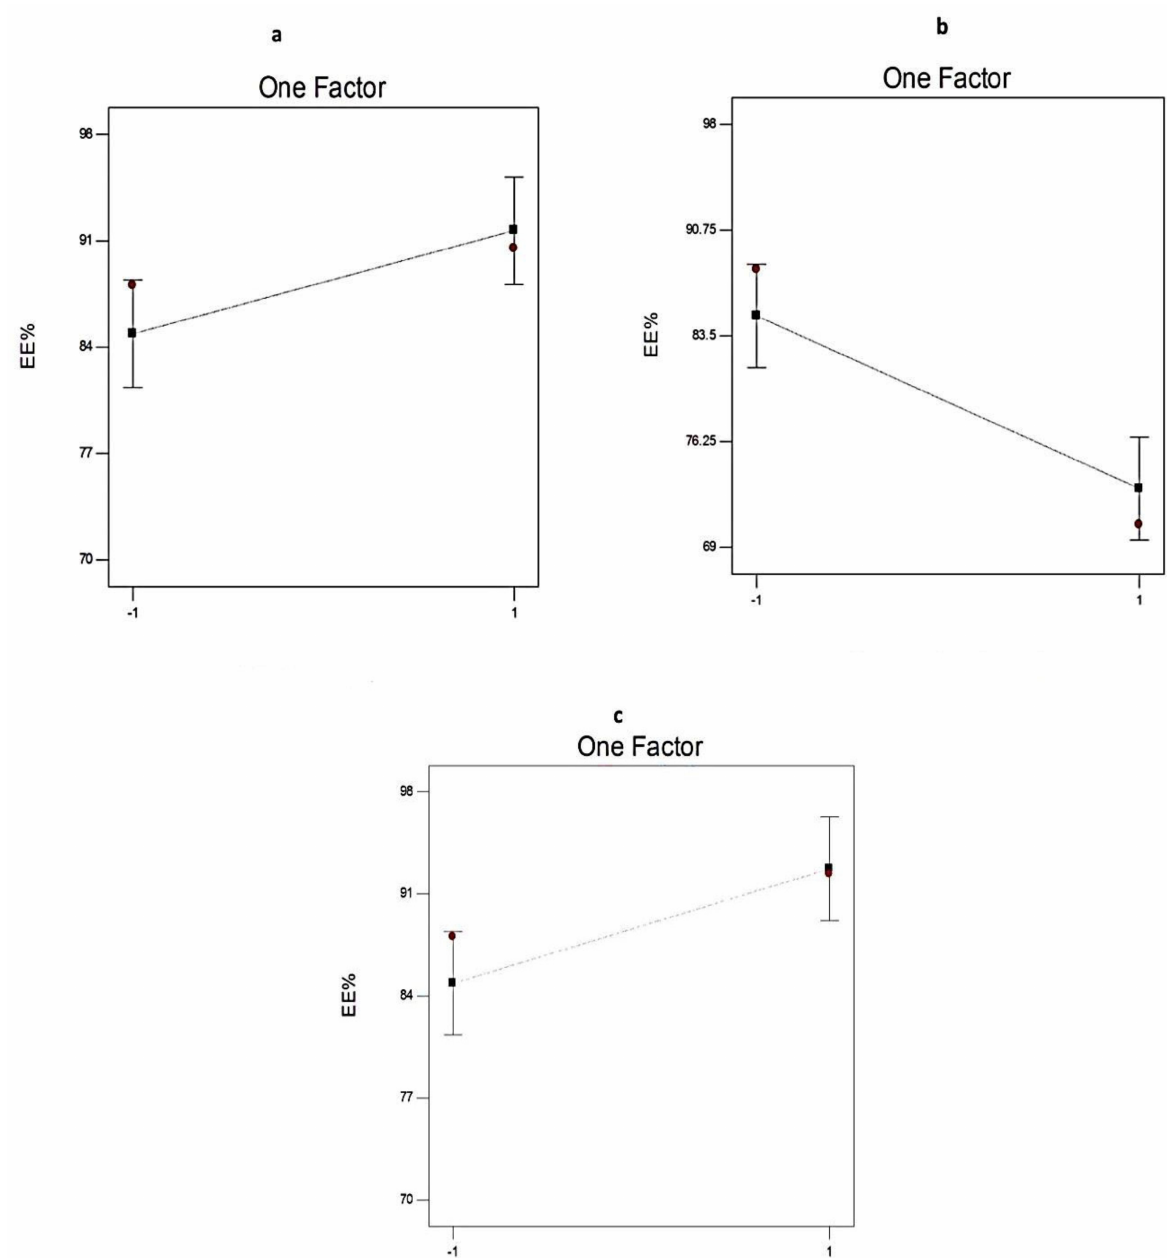
Figure 5. The effect of different independent variables ( a ) ratio of Span to EA, ( b ) type of non-ionic surfactant, and ( c ) type of EA on EE% of EGCG-loaded spanlastics according to 2 3 factorial design. Abbreviation: EE, entrapment efficiency; EA, edge activator; EGCG, epigallocatechin